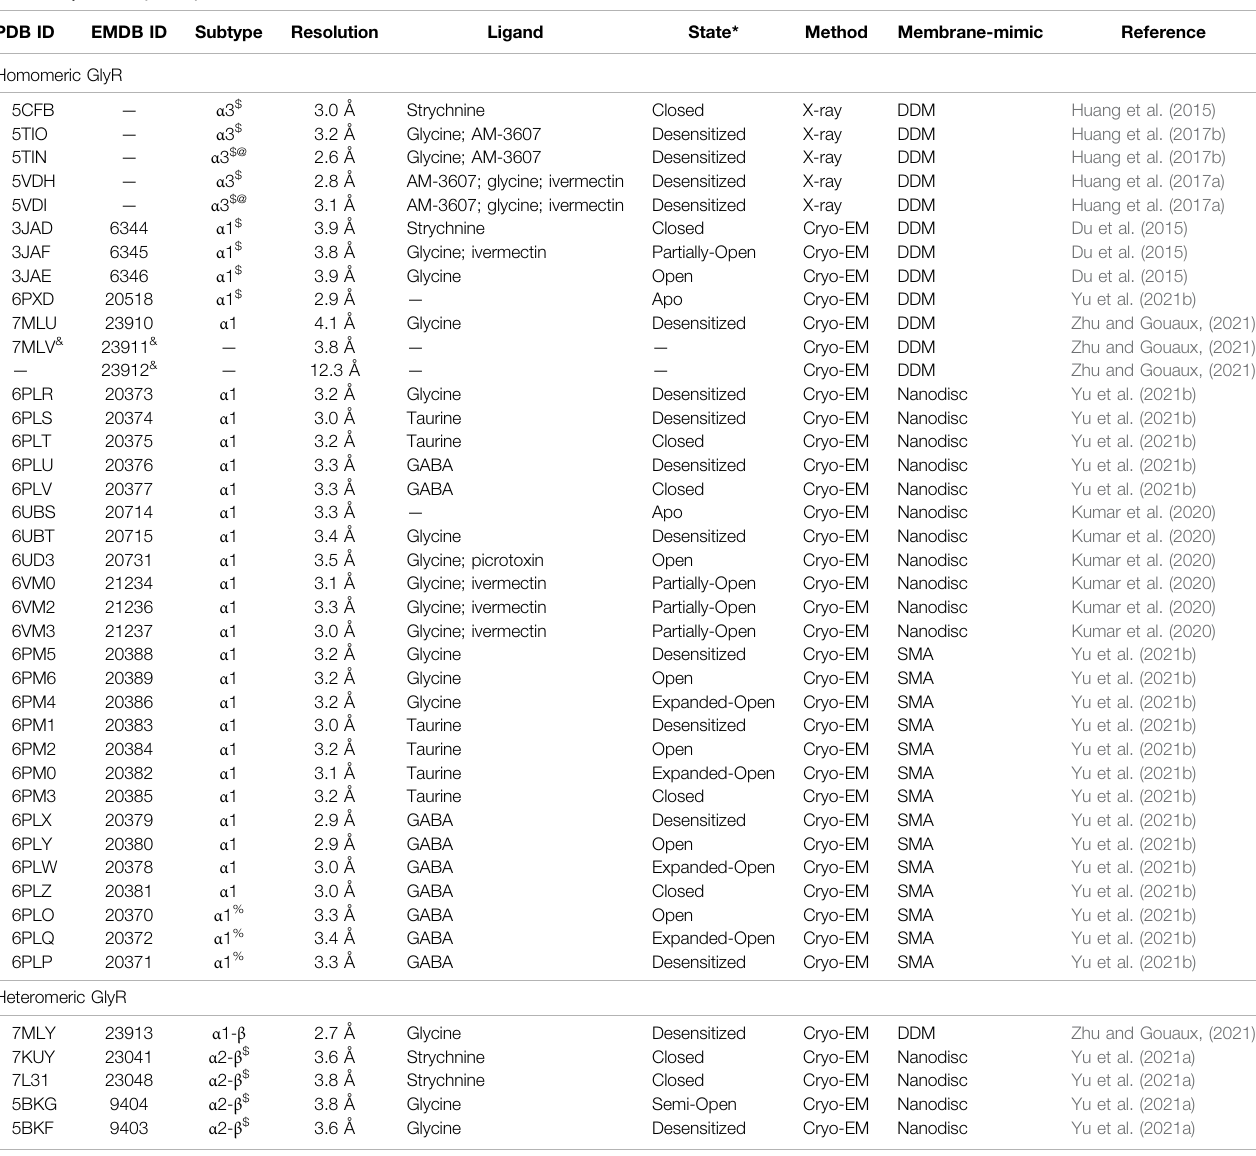
TABLE 1 | Summary of GlyR structures. PDB